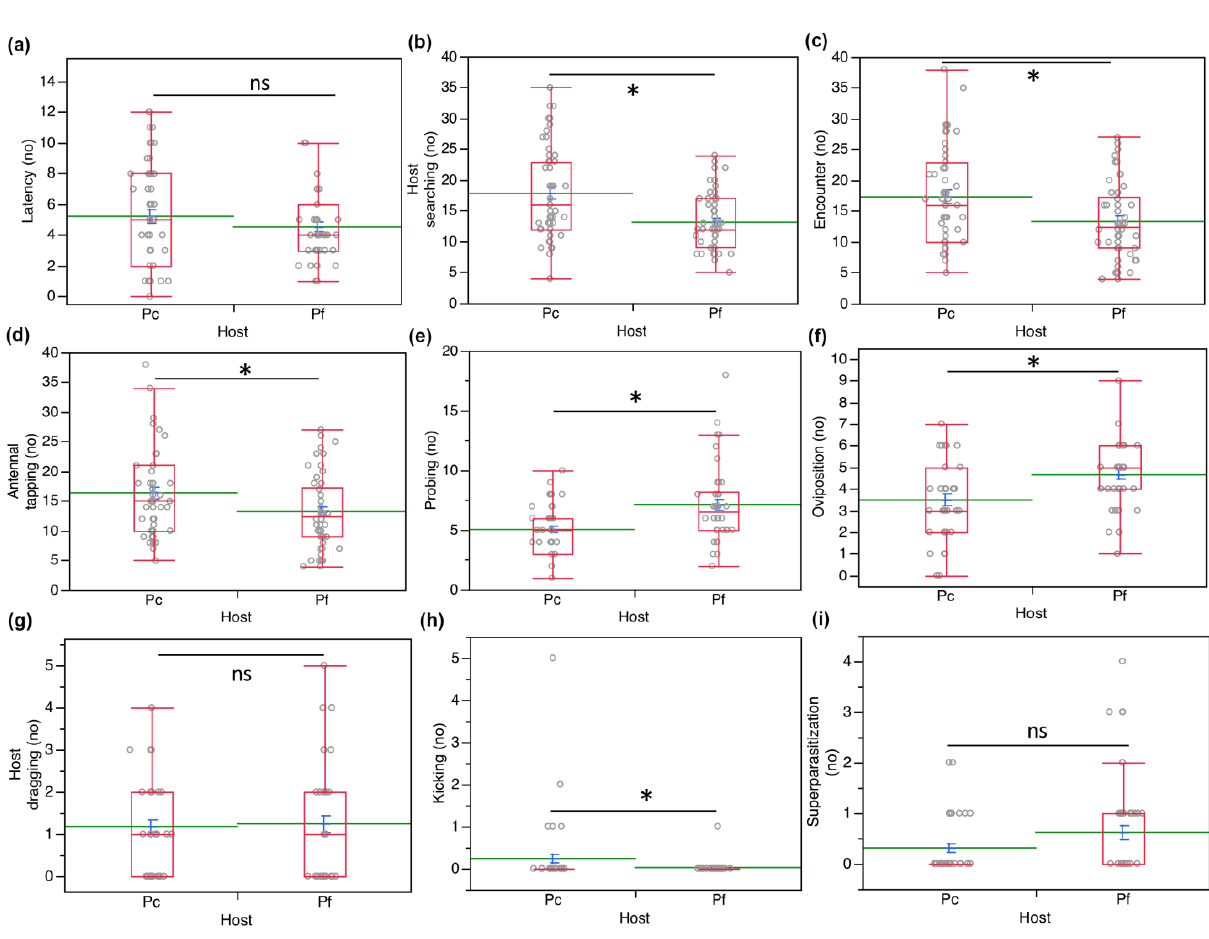
Figure 5. Frequency (no.) of different behavioral parameters performed by Anagyrus vladimiri approaching Pseudococcus comstocki (Pc) and Planococcus ficus (Pf) in no-choice tests: ( a ) latency, ( b ) host searching, ( c ) host encounter, ( d ) antennal tapping, ( e ) probing, ( f ) oviposition, ( g ) host dragging, ( h ) kicking (fast abdominal rocking movement against the parasitoid), and ( i ) superparasitization. Each box plot indicates the median (central line) and its range of dispersion (lower and upper quartiles and outliers); green lines indicate the means, while light blue T-bars indicate standard errors. Asterisks indicate significant differences (Kruskal–Wallis test, p < 0.05), ns = not significant.